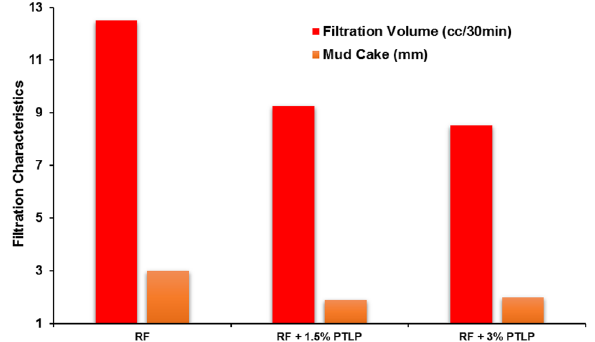
Fig. 4 The influence of PTLP on the filtration characteristics (fresh conditions)